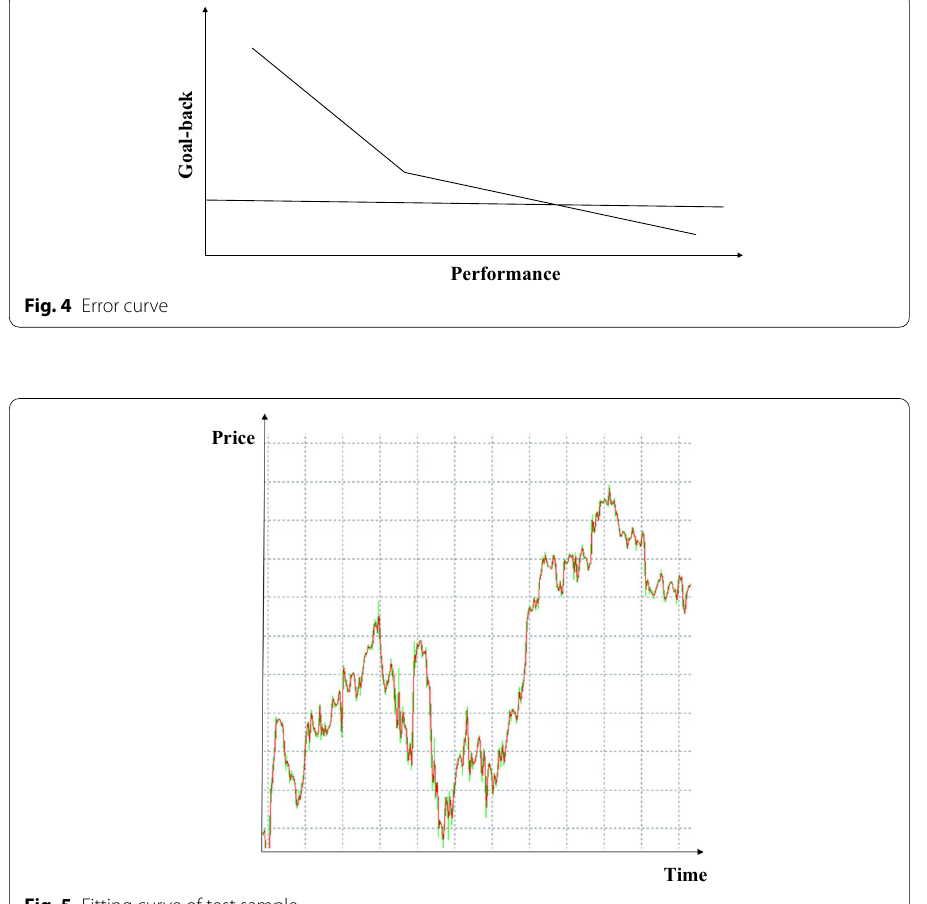
Fig. 5 Fitting curve of test